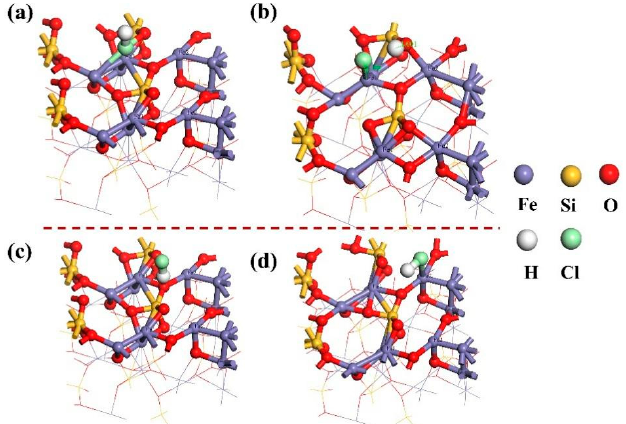
Figure 5. HCl adsorption on Fe 2 SiO 4 : ( a ) Configuration of HCl vertical adsorption with H atom near one O atom before optimization and ( b ) after optimization. ( c ) Configuration of HCl vertical adsorption with Cl atom near one Fe atom before optimization and ( d ) after optimization.